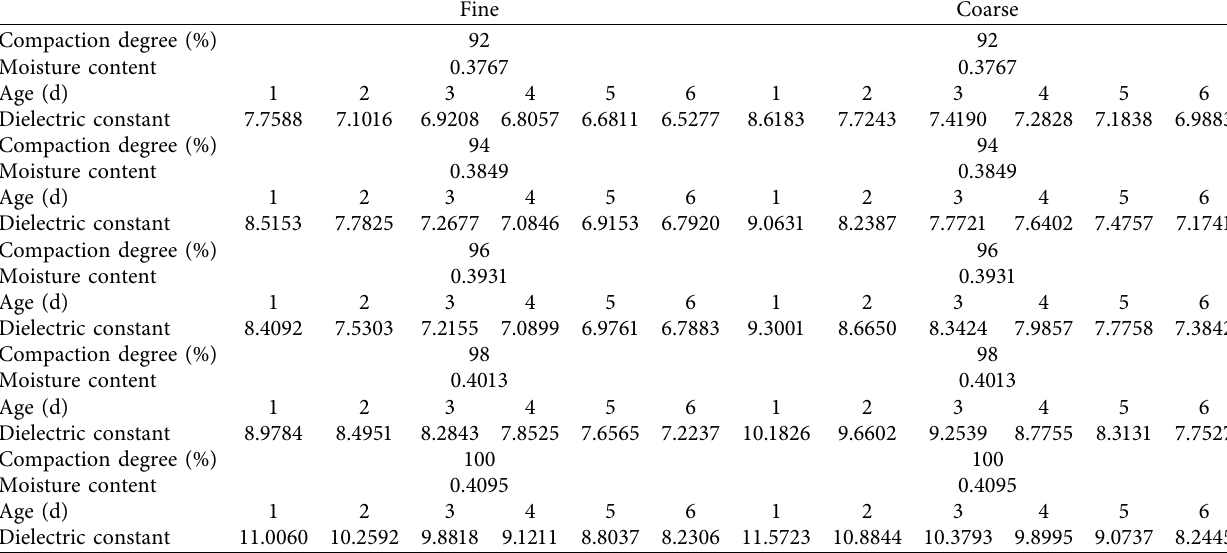
Table 4: Summary of the measured dielectric constant and the influencing